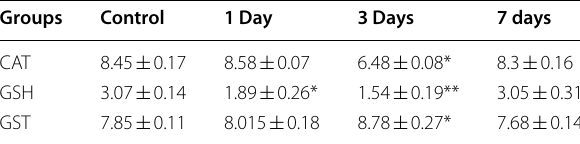
*Significant at p <